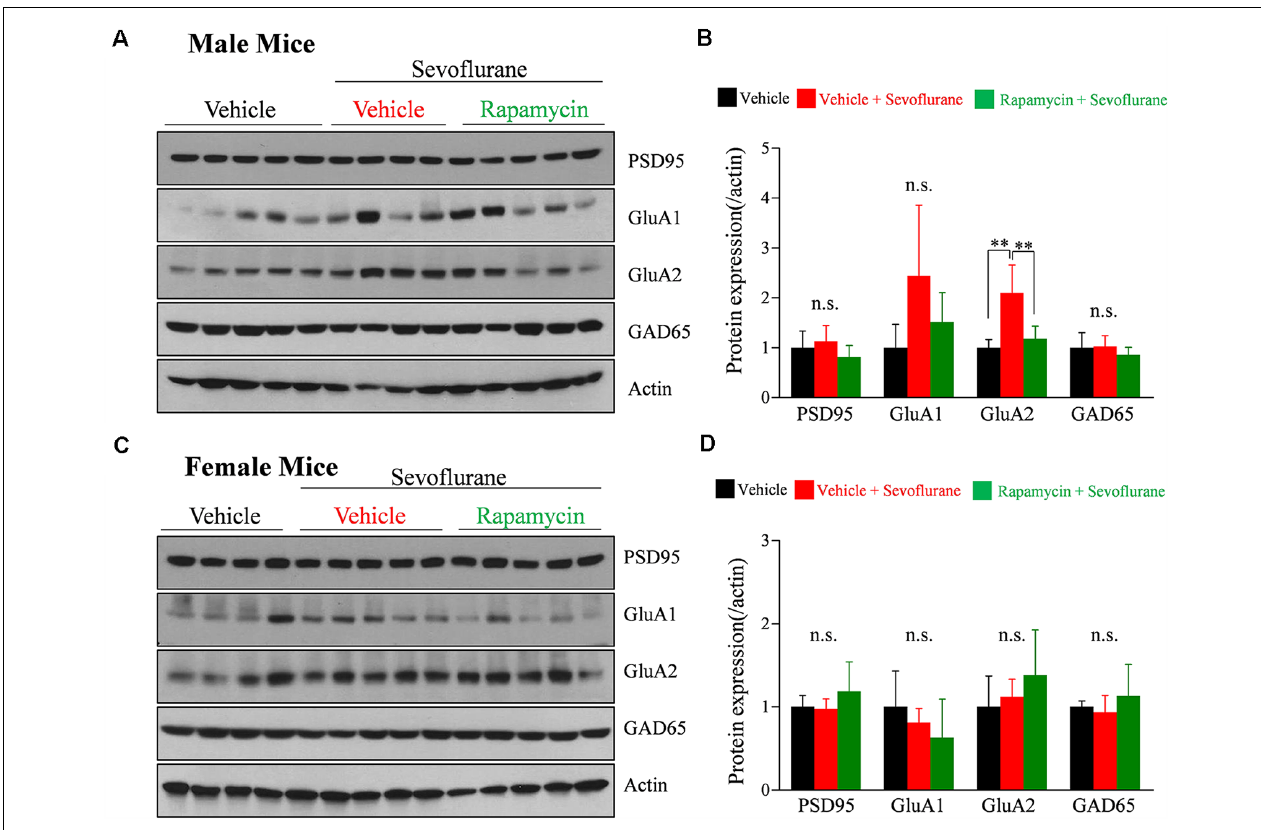
FIGURE 3 | Rapamycin prevents the sevoflurane-induced increase in the expression of the α -amino-3-hydroxy-5-methyl-4-isoxazolepropionate (AMPA) receptor subunit GluA2 in PND 16/17 male mice. (A–D) Western blotting of whole-brain samples obtained 24 h after sevoflurane exposure for expression of excitatory {postsynaptic density 95 [PSD95], GluA1, GluA2} and inhibitory (GAD65) synaptic proteins. Actin was used as the loading control. (B,D) Mean ± SD protein band intensity in panels ( A,C ; n = 4 or 5 per group; n.s., not significant, ∗∗ p <